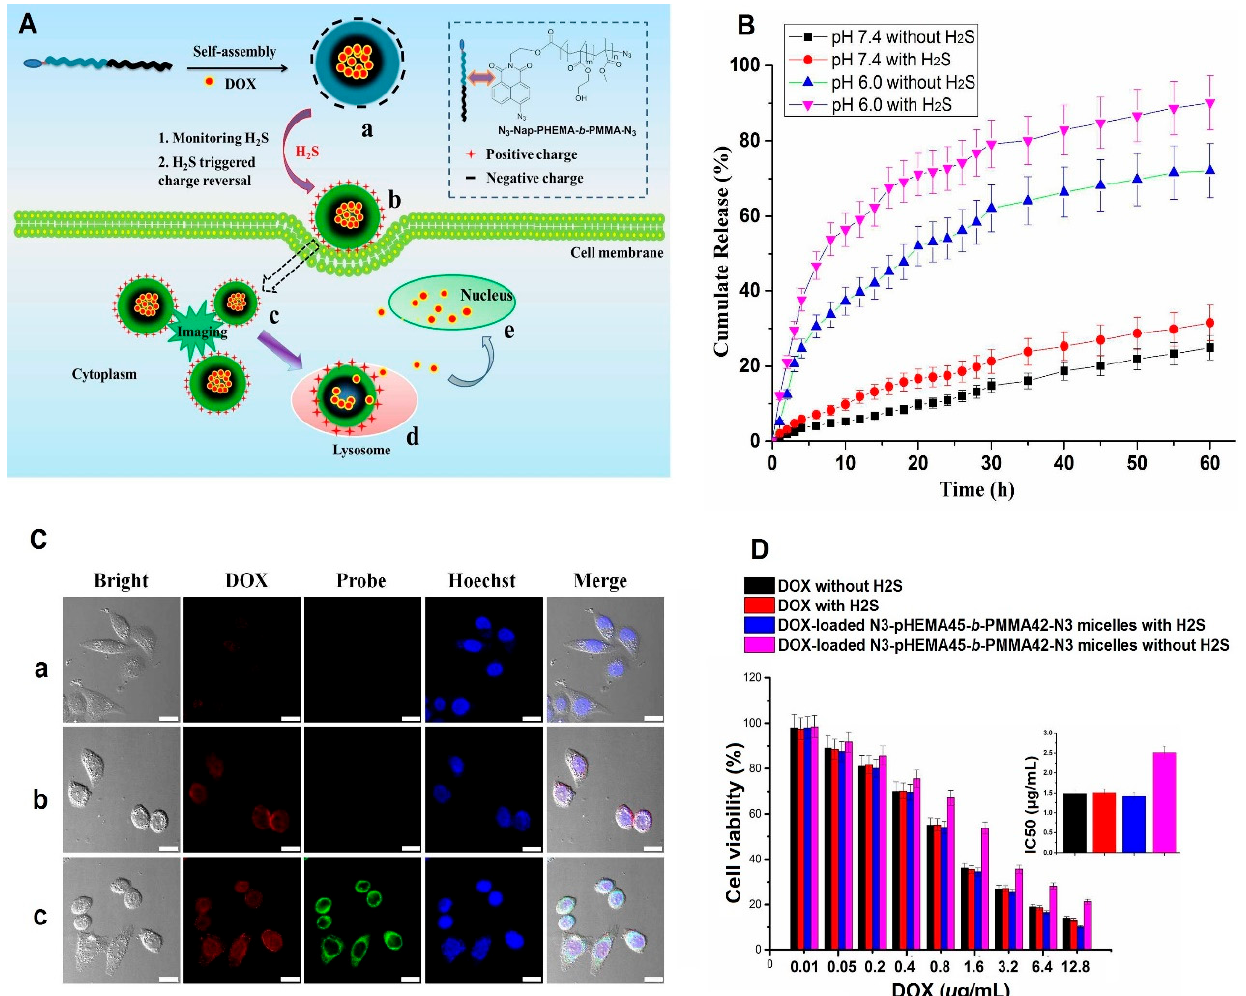
Figure 5. The mechanism of the drug-loaded hydrogen sulfide-responsive micelles when exposed to the stimulant is depicted schematically ( A ); the drug release rates of the drug-loaded N3-Nap-pHEMA-b-PMMA-N3 sample at acidic and physiological environments, with/without being exposed to hydrogen sulfide ( B ); the images of HeLa cells treated with doxorubicin ( a ), drug-loaded N3-Nap-pHEMA-b-PMMA-N3 without hydrogen sulfide ( b ), and drug-loaded N3-Nap-pHEMA-b-PMMA-N3 with hydrogen sulfide ( c ), taken by confocal microscopy (scale bar = 20 µ m) ( C ); the cell viability (%) of drug and non-loaded samples, with/without being exposed to hydrogen sulfide ( D ). Reprinted from [16], with permission from the American Chemical Society.